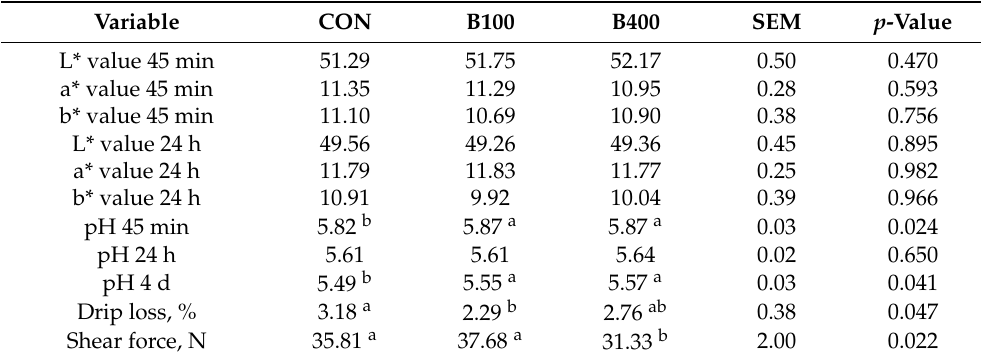
Table 8. Effects of dietary supplementation with bilberry extract on meat quality of yellow-feathered chickens at 63 d 1 .